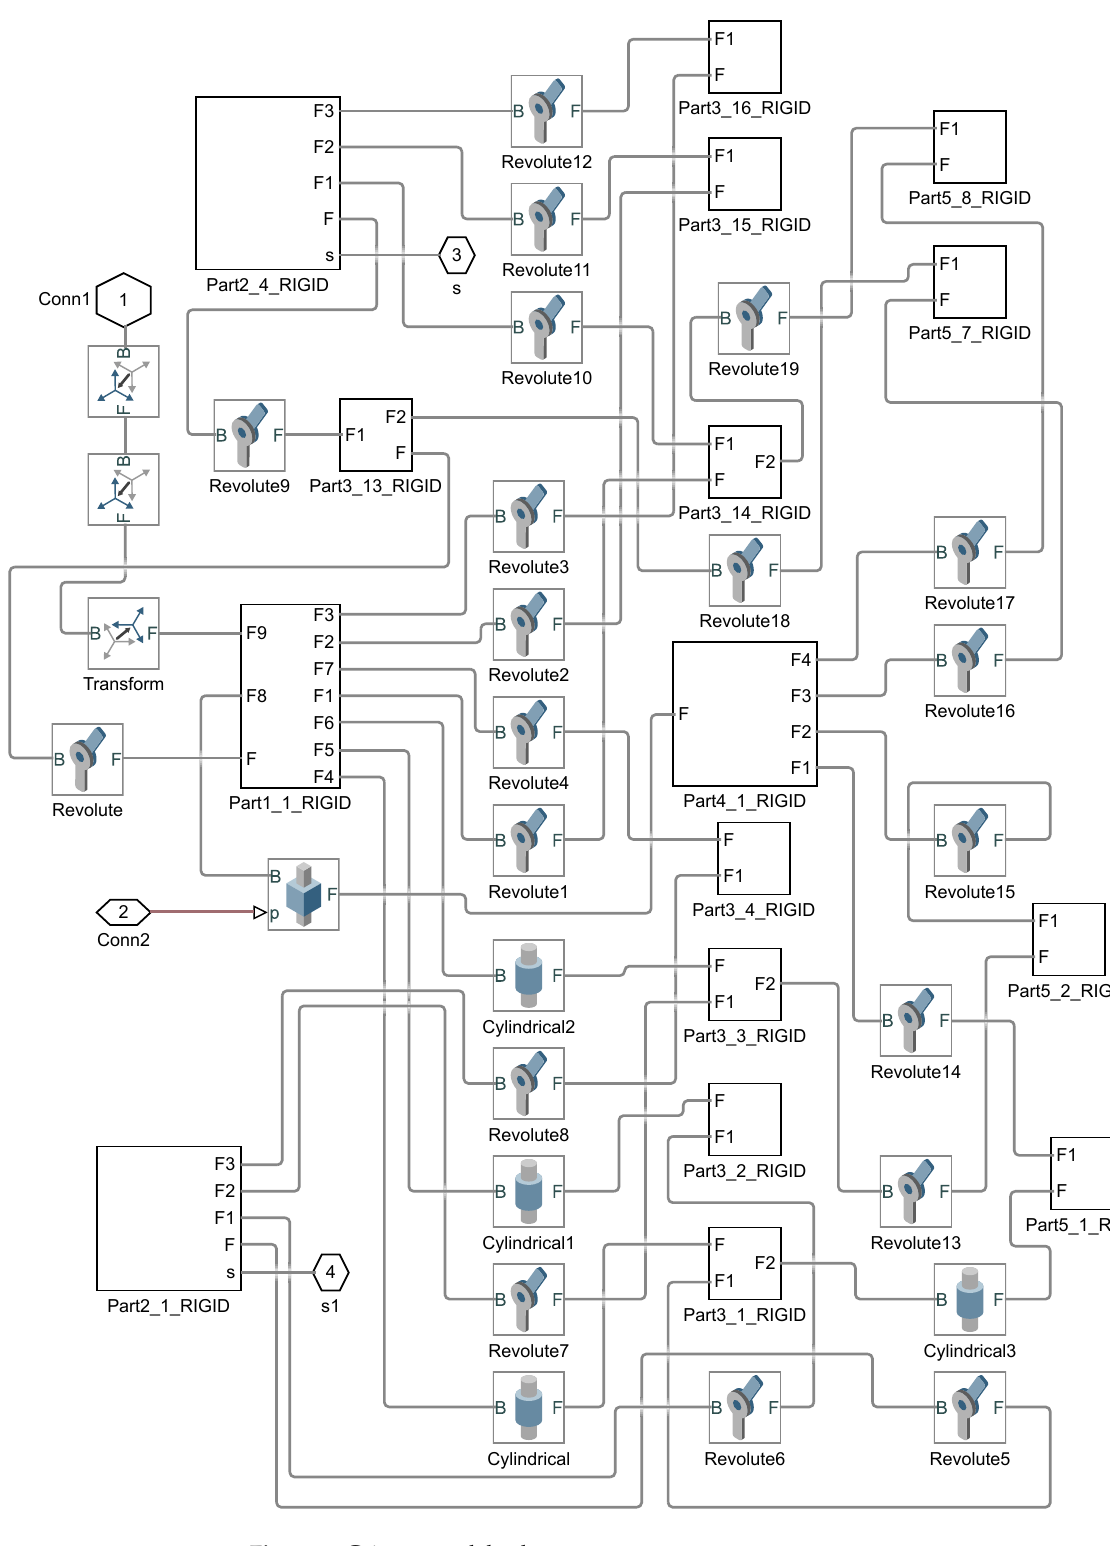
Figure 6. Gripper model